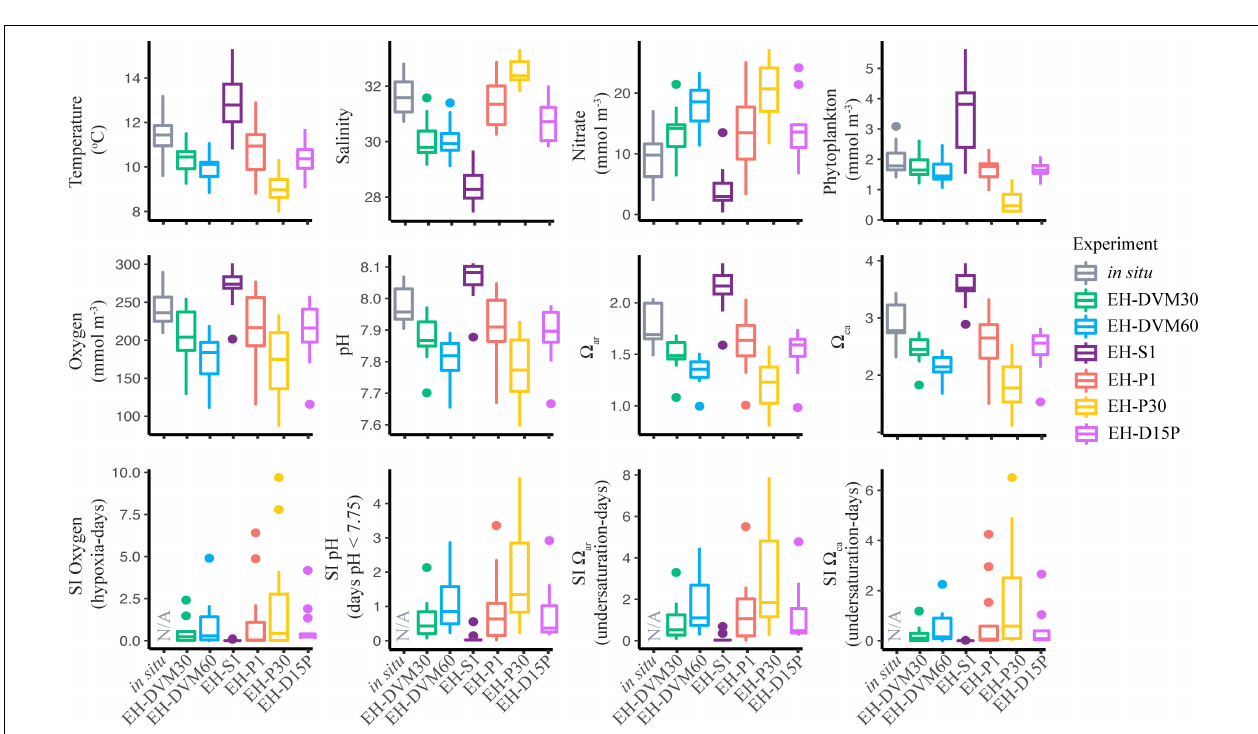
FIGURE 5 | In situ conditions and particle tracking exposure histories differed among years and among simulations with different particle behaviors and initialization depths. These box and whisker plots show the interquartile range (bounds of the box) with a horizontal line at the median, ends of the vertical lines at the fifth and 95th percentiles, and outliers represented by dots. Averages were calculated across all particles within an in situ extraction or particle tracking simulation, and statistics were calculated across survey averages to show variability over time (2009–2017; see Supplementary Table 4 for ANOVA results).